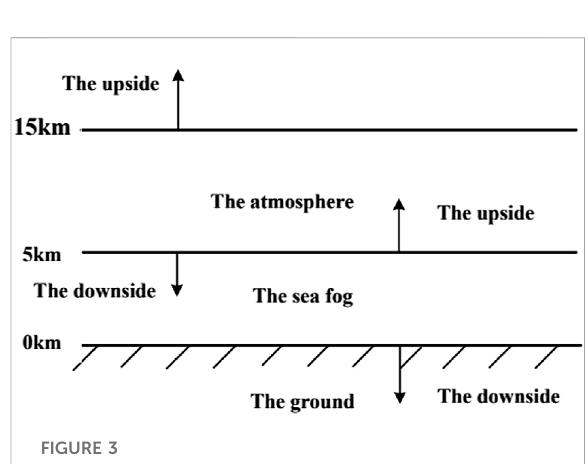
FIGURE 3 Strati fi cation of the atmospheric and sea fog